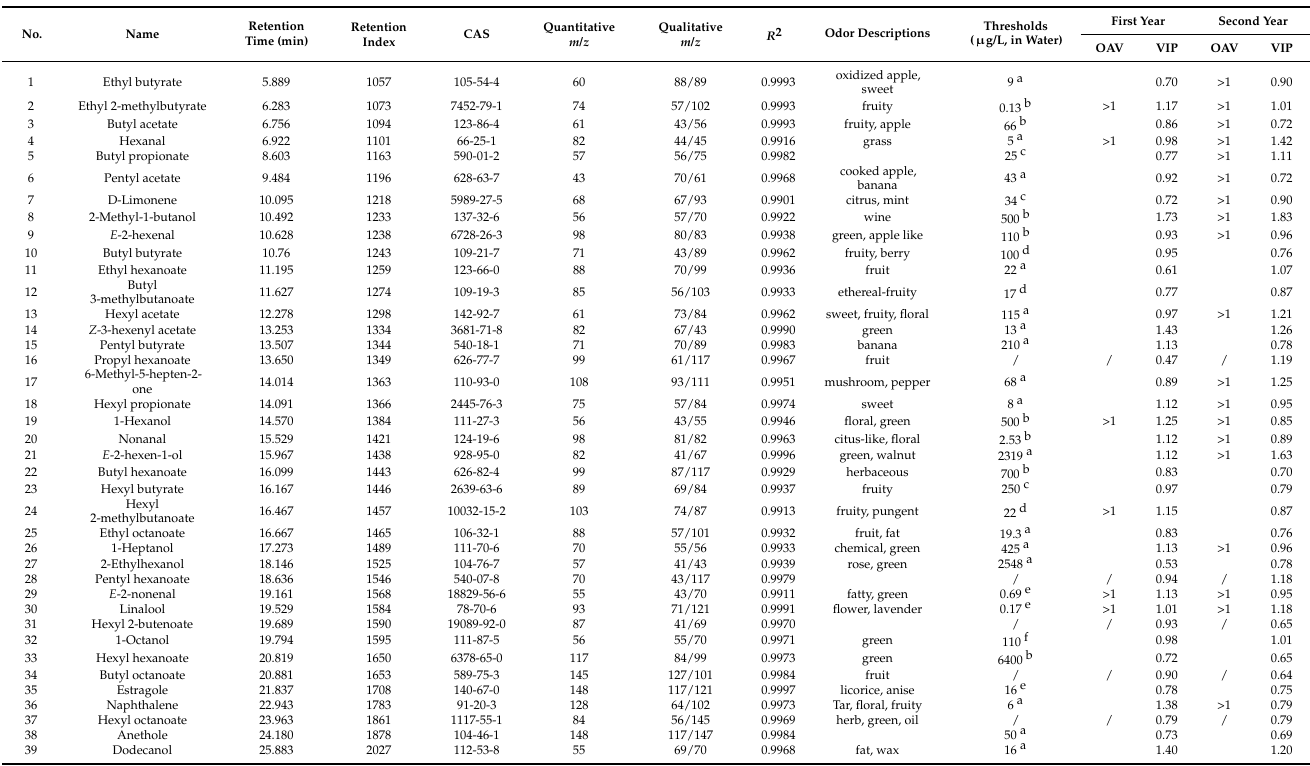
Table 2. List of identified volatile compound information, including retention time, retention index, CAS number, quantitative m / z , qualitative m / z , R 2 , odor description, threshold, OAV values and VIP values in PLS-DA over two